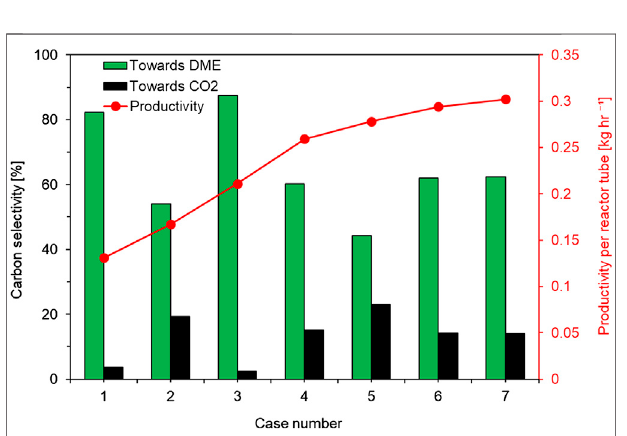
FIGURE5| Resultsofthedynamiccyclemodelingshowingthetrade-off between carbon selectivity and productivity for the chosen three columns SEDMES cycle